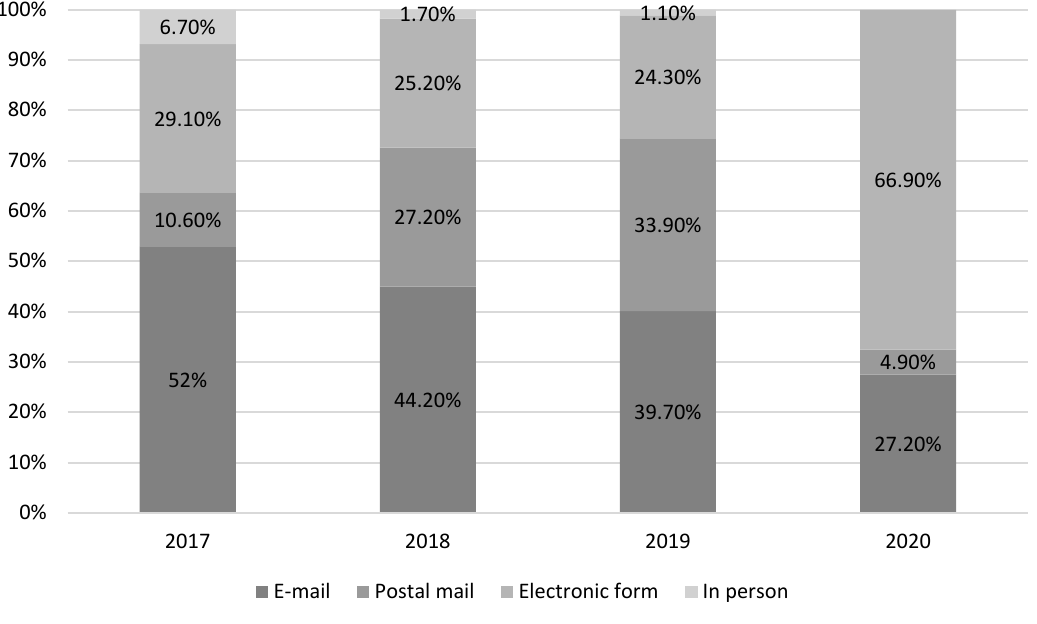
Figure 2. Means of complaints presented to CICDR ( n )—2017 to2020. Source: Data retrieved from